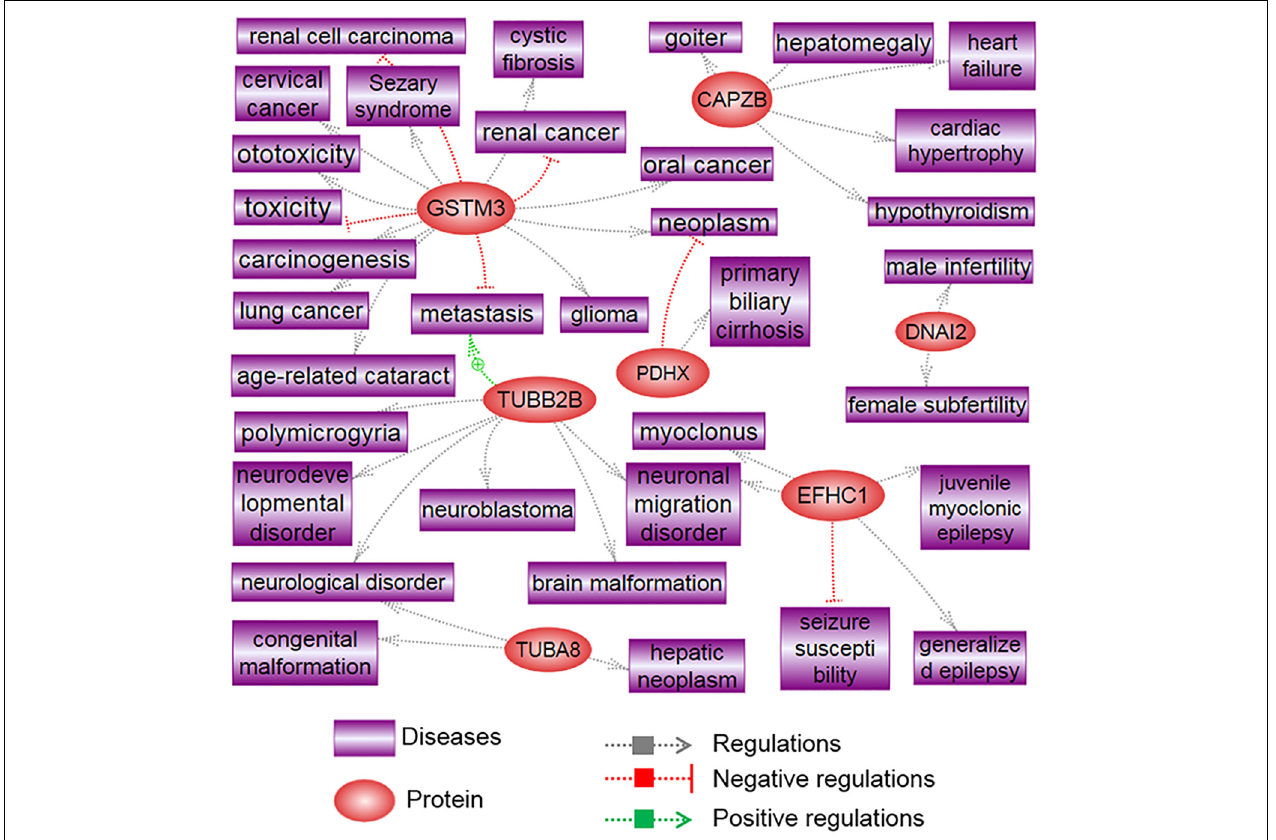
FIGURE 3 | Signaling pathways associated with highly differentiated proteins in Y spermatozoa. The illustration was prepared using Pathway Studio (Elsevier R (cid:13) , Ariadne Genomics, Inc.) after performing a literature search in the PubMed